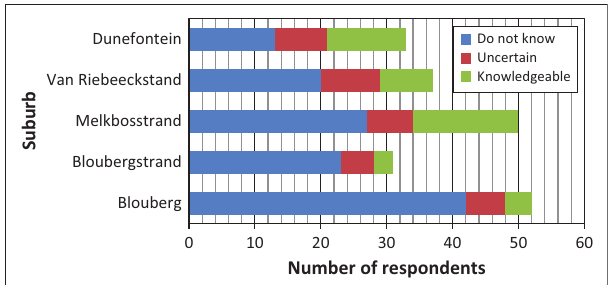
FIGURE 5: Respondents’ knowledge of evacuation routes out of Formal Emergency Planning